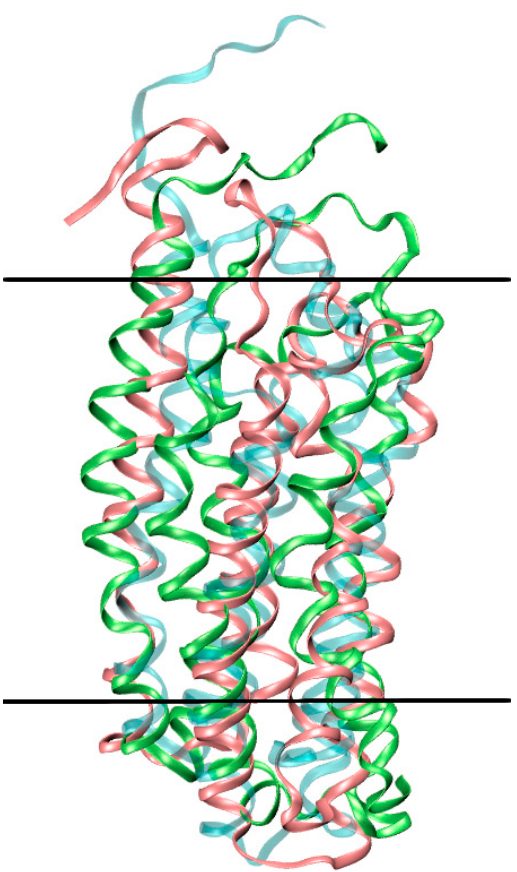
Figure 4. Distortion of mTSPO_NMR_monomer in the lipid bilayer. The initial NMR structure (cyan) is superimposed to mTSPO_NMR_monomer in complex with PK11195 (green) and mTSPO_NMR_monomer without ligand (pink) after MD equilibration. The boundaries of the membrane are approximately shown as black lines.